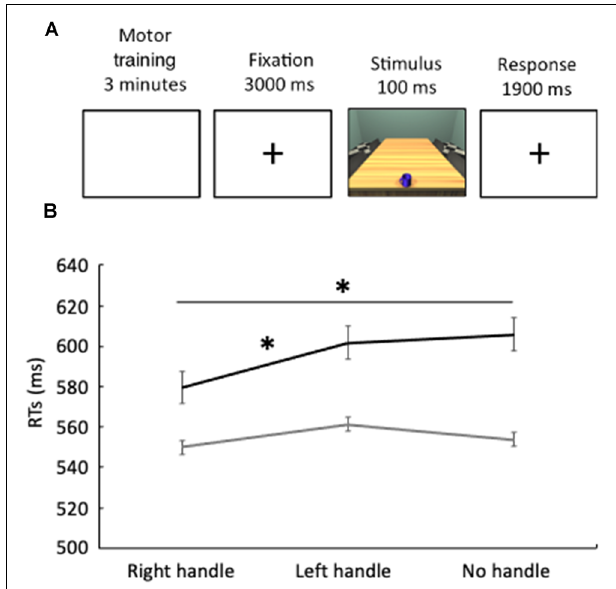
FIGURE 1 | (A) Temporal structure of Experiments 1 and 2. (B) The black line represents reaction times, expressed in milliseconds, in Experiment 1 (reach-to-grasp), while the gray line represents reaction times in Experiment 2 (reach-to-touch). Error bars indicate standard errors. * p <